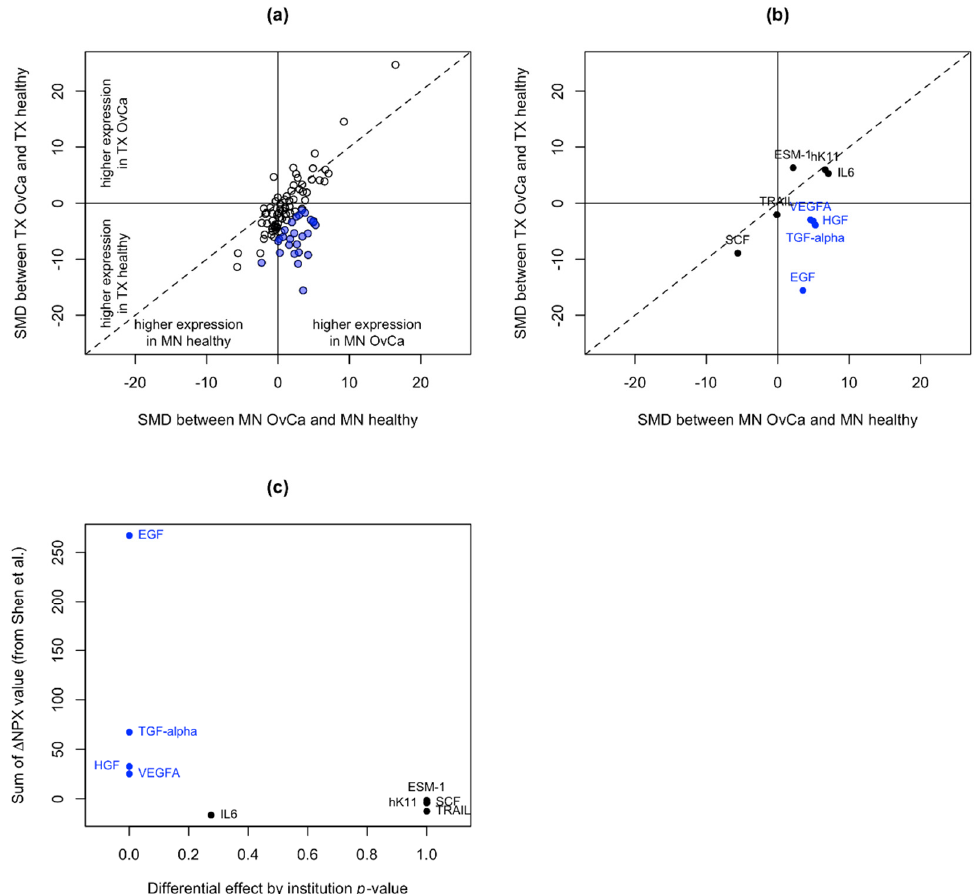
Figure 1. Defining proteins that may be sensitive to preanalytical variation. ( a ) The standardized mean differences (SMDs, i.e., t -statistics) in protein levels between those with and without cancer were compared for Texas (TX) vs. Minnesota (MN). Blue points are proteins that were significantly differentially expressed between institutions (e.g., overexpressed in MN cancers vs. underexpressed in TX cancers). ( b ) The same plot as in ( a ), except only the proteins tested to determine their preanalytical variation in Shen et al. [13] are plotted. ( c ) Shen et al.’s measurement of protein instability (sum of ∆ NPX values; higher values indicate more instability) was compared to the p -values for differential effects by institution, where small p -values are evidence of instability. The differential effect by institution p -values for all differentially expressed proteins are in Table S1, along with the mean differences by institution.